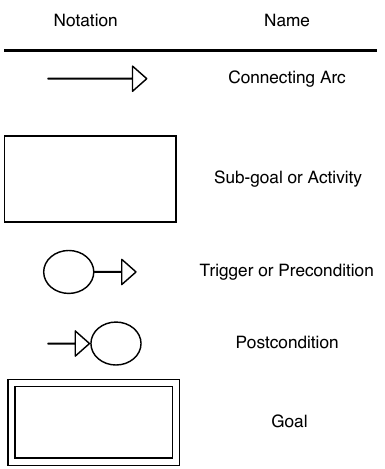
Figure 6. Notation mapping CPN to AOM—based on [60]. In the CPN model, the Rechained protocol execution is modeled using places and transitions thata re connected by directed arcs. The goals of the AOM goal model are mapped to rectangular CPN transitions. Double-boarded transitions are used to indicate sub-goals and hierarchically structured CPN modules. The CPN modules and sub-modules of the overall CPN model map to the relation between goals and sub-goals of the AOM goal model, as illustrated in Figure 7. The triggers and pre-conditions of the AOM behavior interfaces are displayed as places with outgoing arcs, while post-conditions are represented by places with incoming arcs